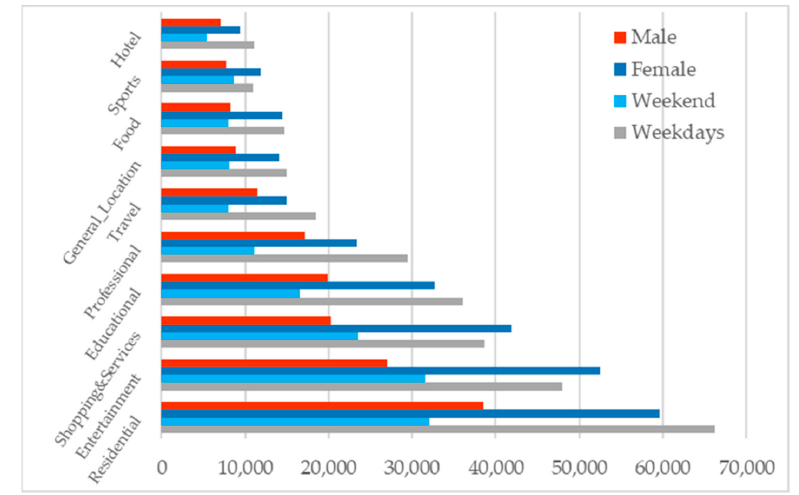
Figure 4. Venue categorization statistics.